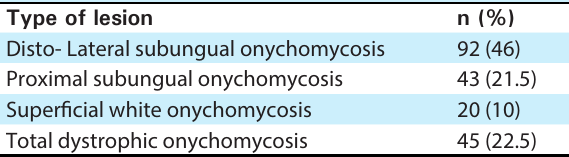
Table 4. Distribution of superficial fungal infection by